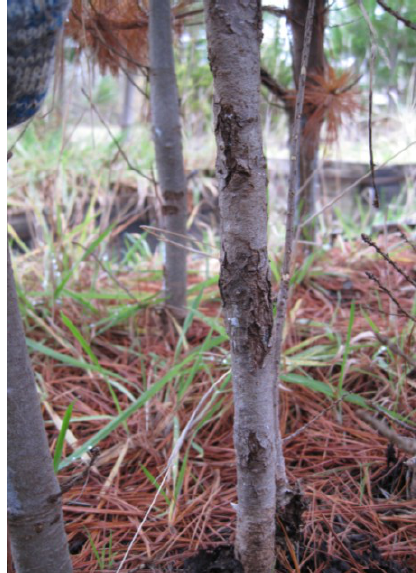
Figure 5. Western white pine tree at Dorena GRC with multiple bark reactions ( left ), five years post-inoculation, in partially resistant family ―75‖ (see Table 1 for details on family ―75‖); and western white pine tree ( right ) in field trial with >300 bark reactions (see [36] for trial